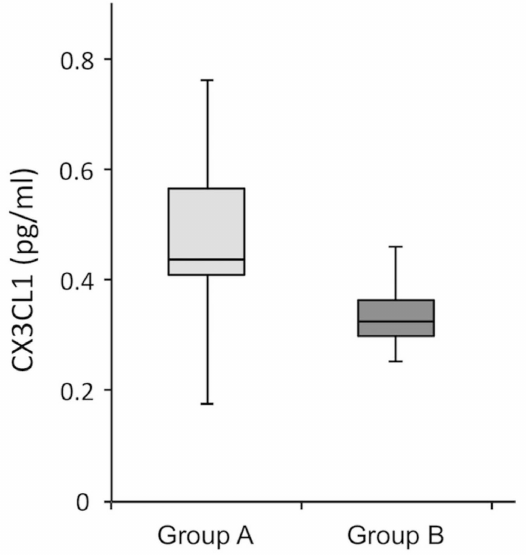
Figure 6. CX3CL1 in the CSF of subjects belonging to Groups A and B. The significance of the differences was evaluated using Student’s t -test ( p < 0.01). Group A is depicted in light gray, and Group B is depicted in dark gray. Table 6. Average values recorded for CX3CL1. The minimum and maximum values are shown in parentheses; σ 2 is the variance of the values according to “one-way ANOVA”. Patients Tot Variable ( n = 46)